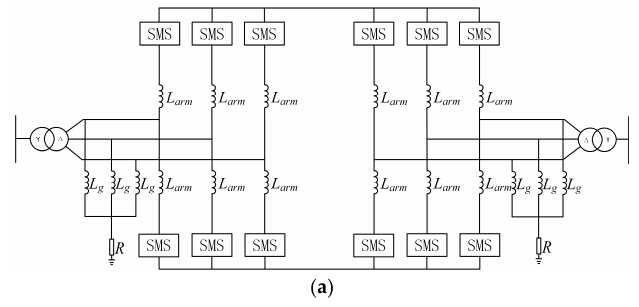
Table 1. Simulation parameters of the test